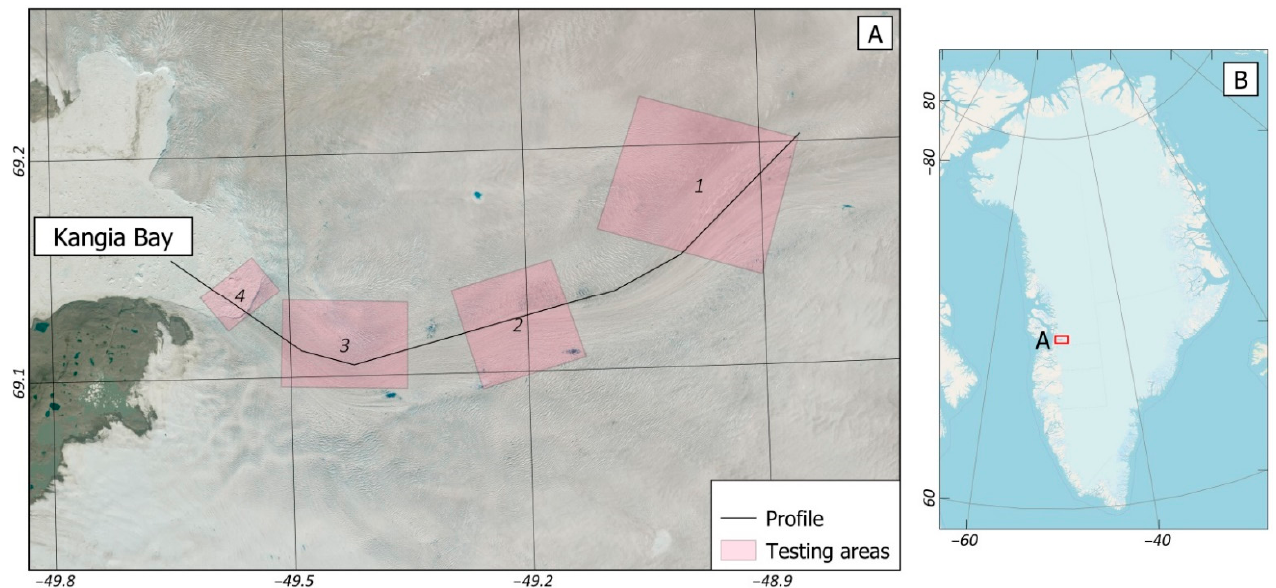
Figure 1. Location of the study area—Jakobshavn Glacier ( A ) in Greenland ( B ) with testing areas and profile).